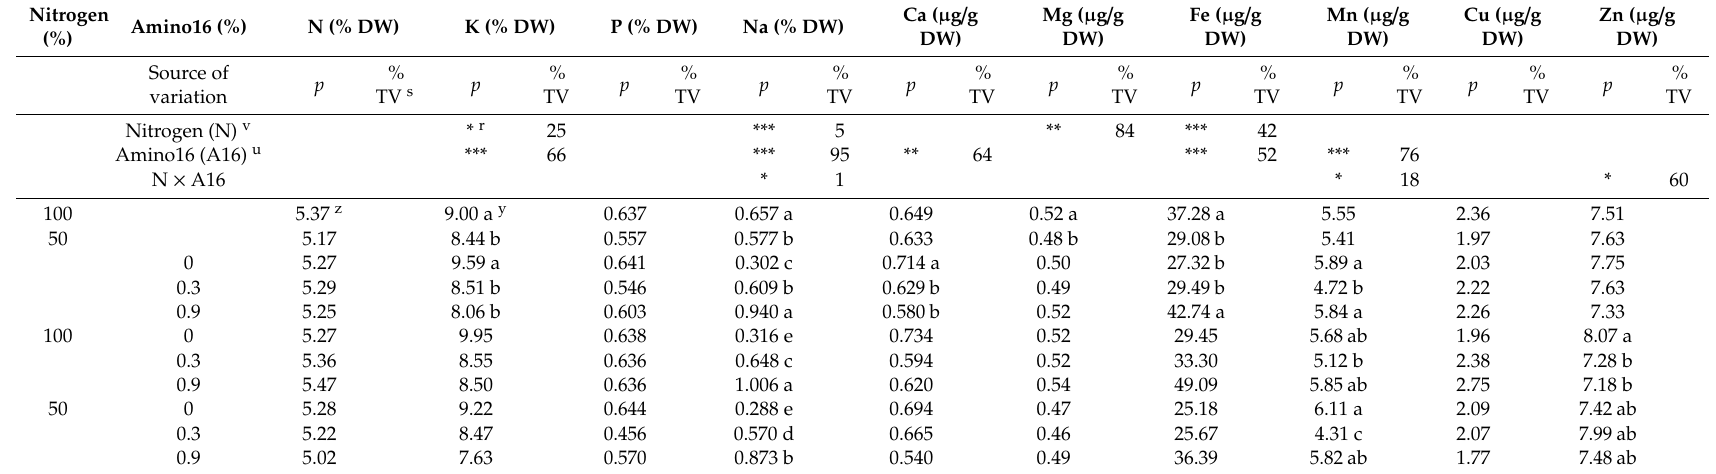
Table 6. Analysis of variance and mean comparison of mineral (N, K, P, Na, Ca, Mg, Fe, Mn, Cu, and Zn) content of red baby lettuce grown in 131 (100%) or 65.5 mg / L (50%) N supplemented with 0, 0.3, or 0.9% Amino16 ®